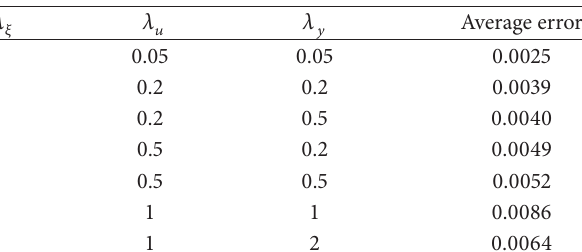
Table 2: Comparison of the estimations for different